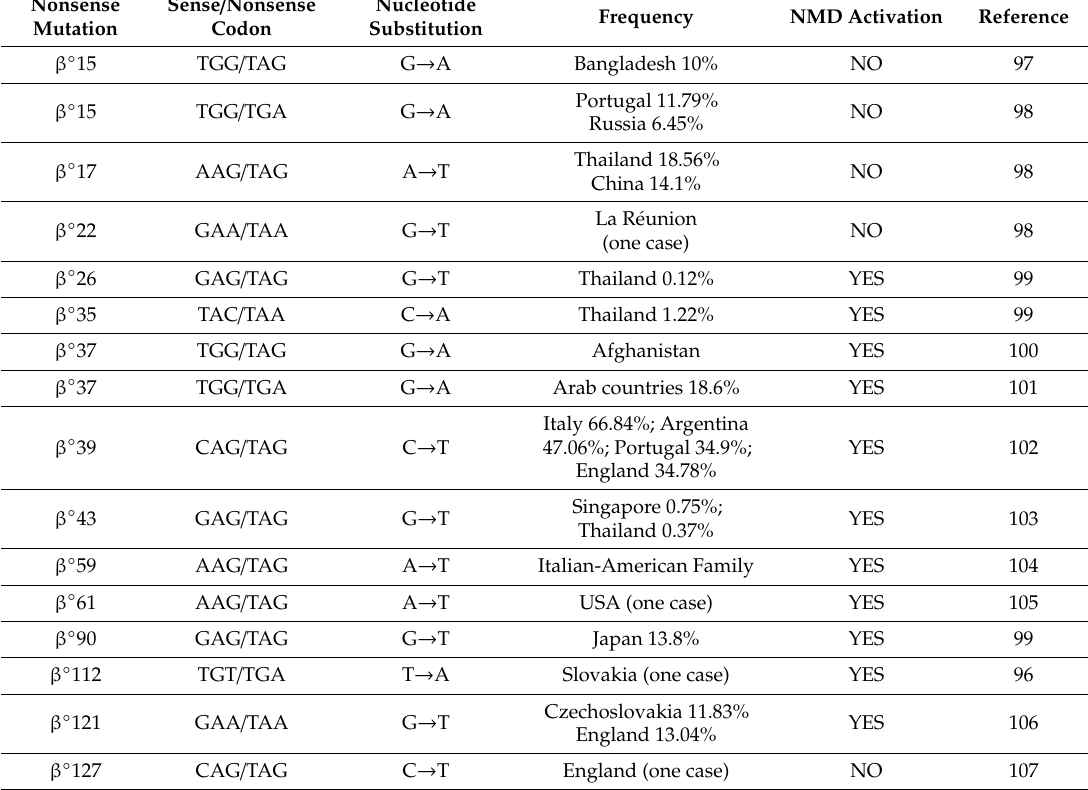
Table 1. β -thalassemia nonsense mutations. For each mutation, sense codon, stop codon, nucleotide substitution, relative frequency (indicating the mutation occurrence in a specific country or geographic area based on all the β -thalassemia patients and obtained from the HbVar database and NMD activation are